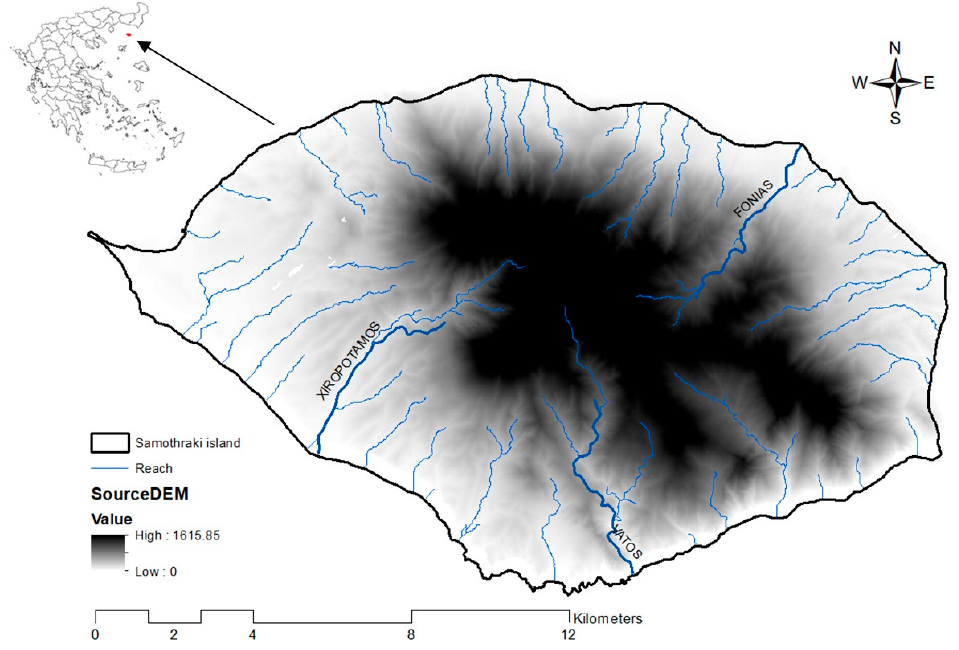
Figure 1. Samothraki Island’s elevations and streams, and location within Greece.